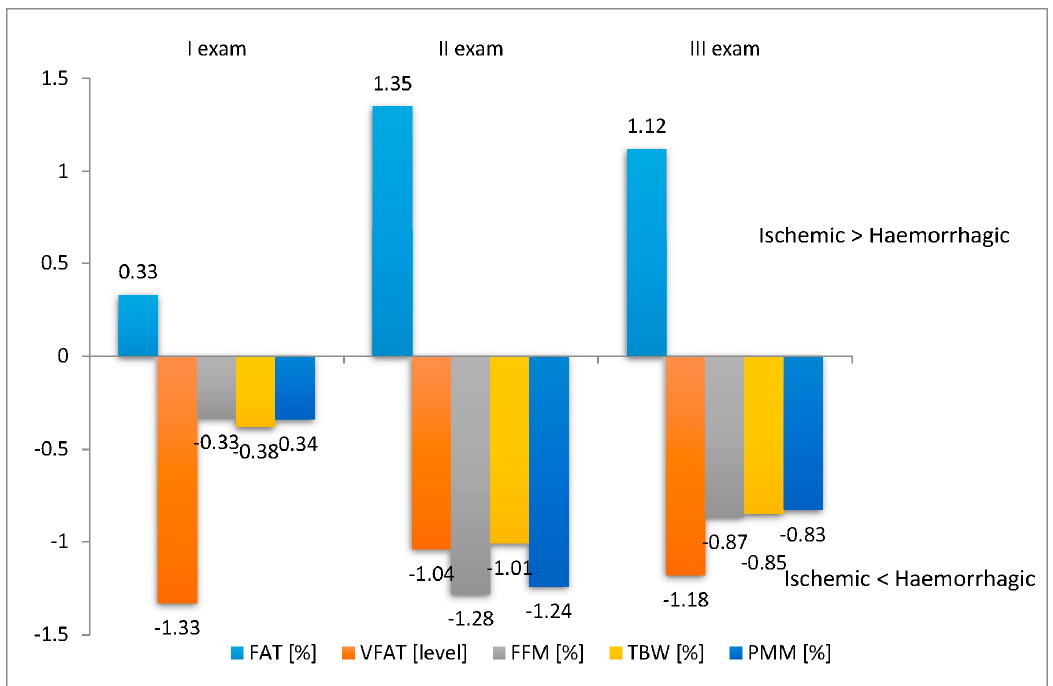
Figure 3. Difference between body mass components versus type of stroke. Figure 3. Di ff erence between body mass components versus type of